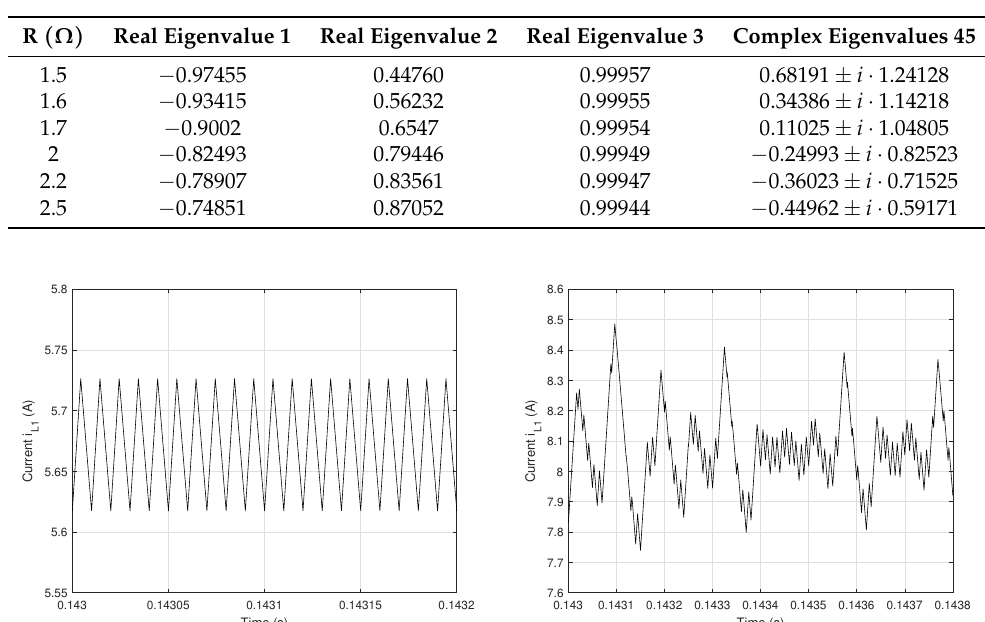
Table 1. Eigenvalues of the monodromy matrix as R is varied in healthy switching case h 1 = h 2 = h 3 = 1.